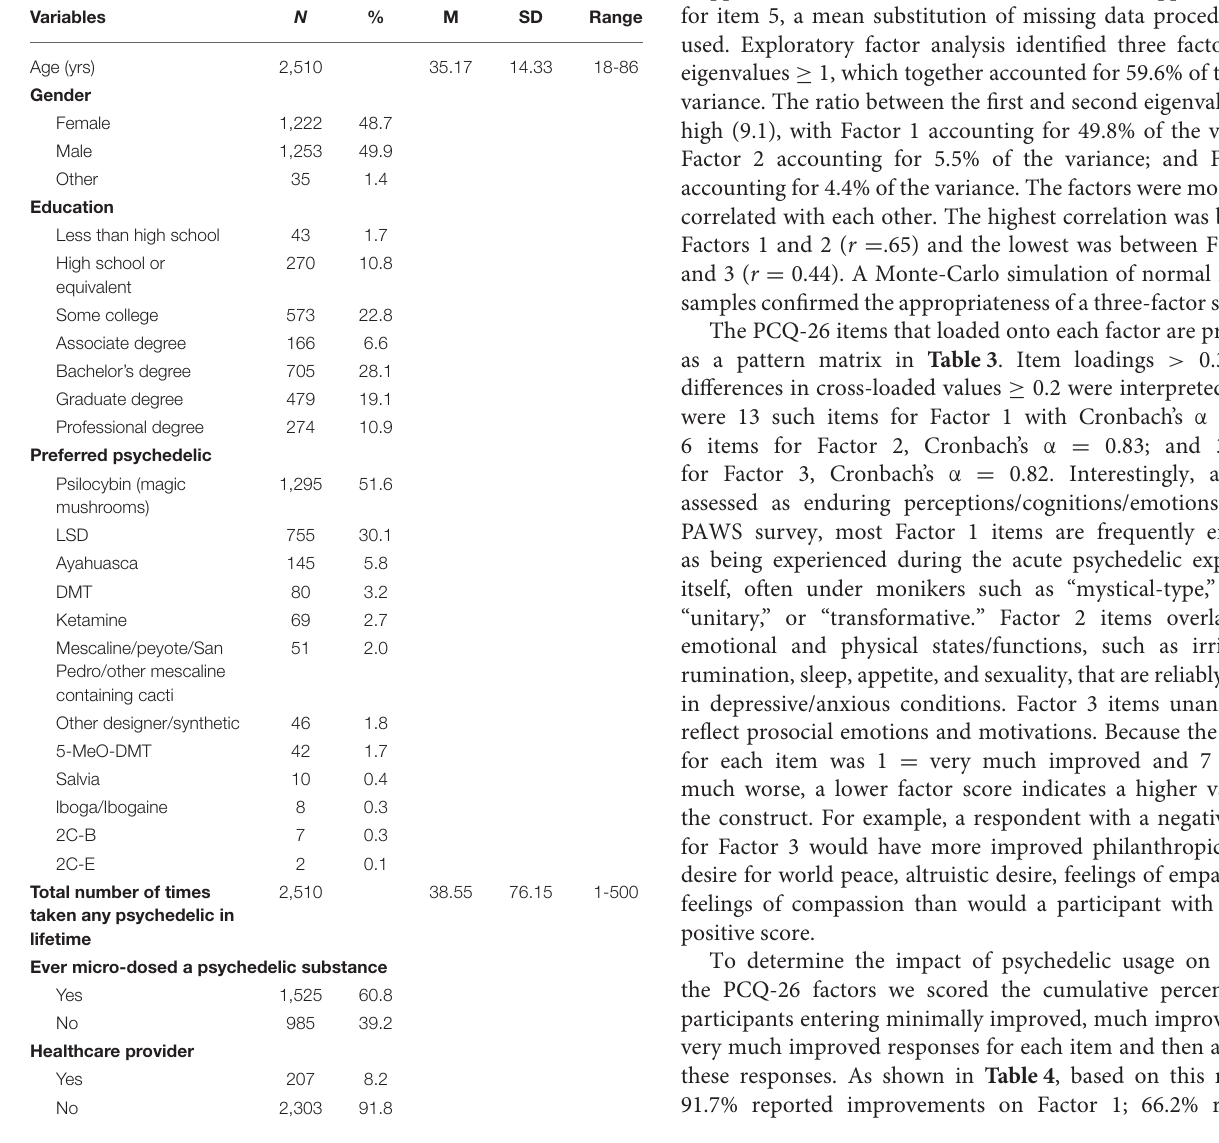
TABLE 1 | Sample characteristics ( N = 2,510).